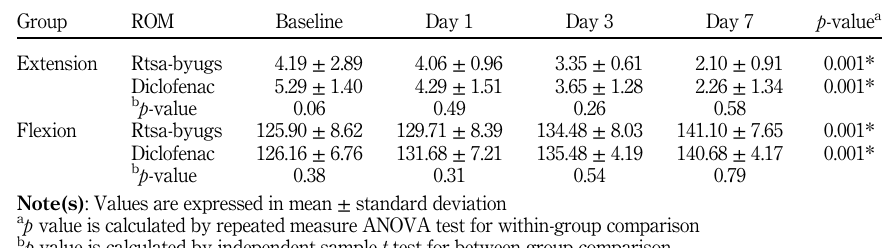
Table 4. The mean score of extension and flexion measured by